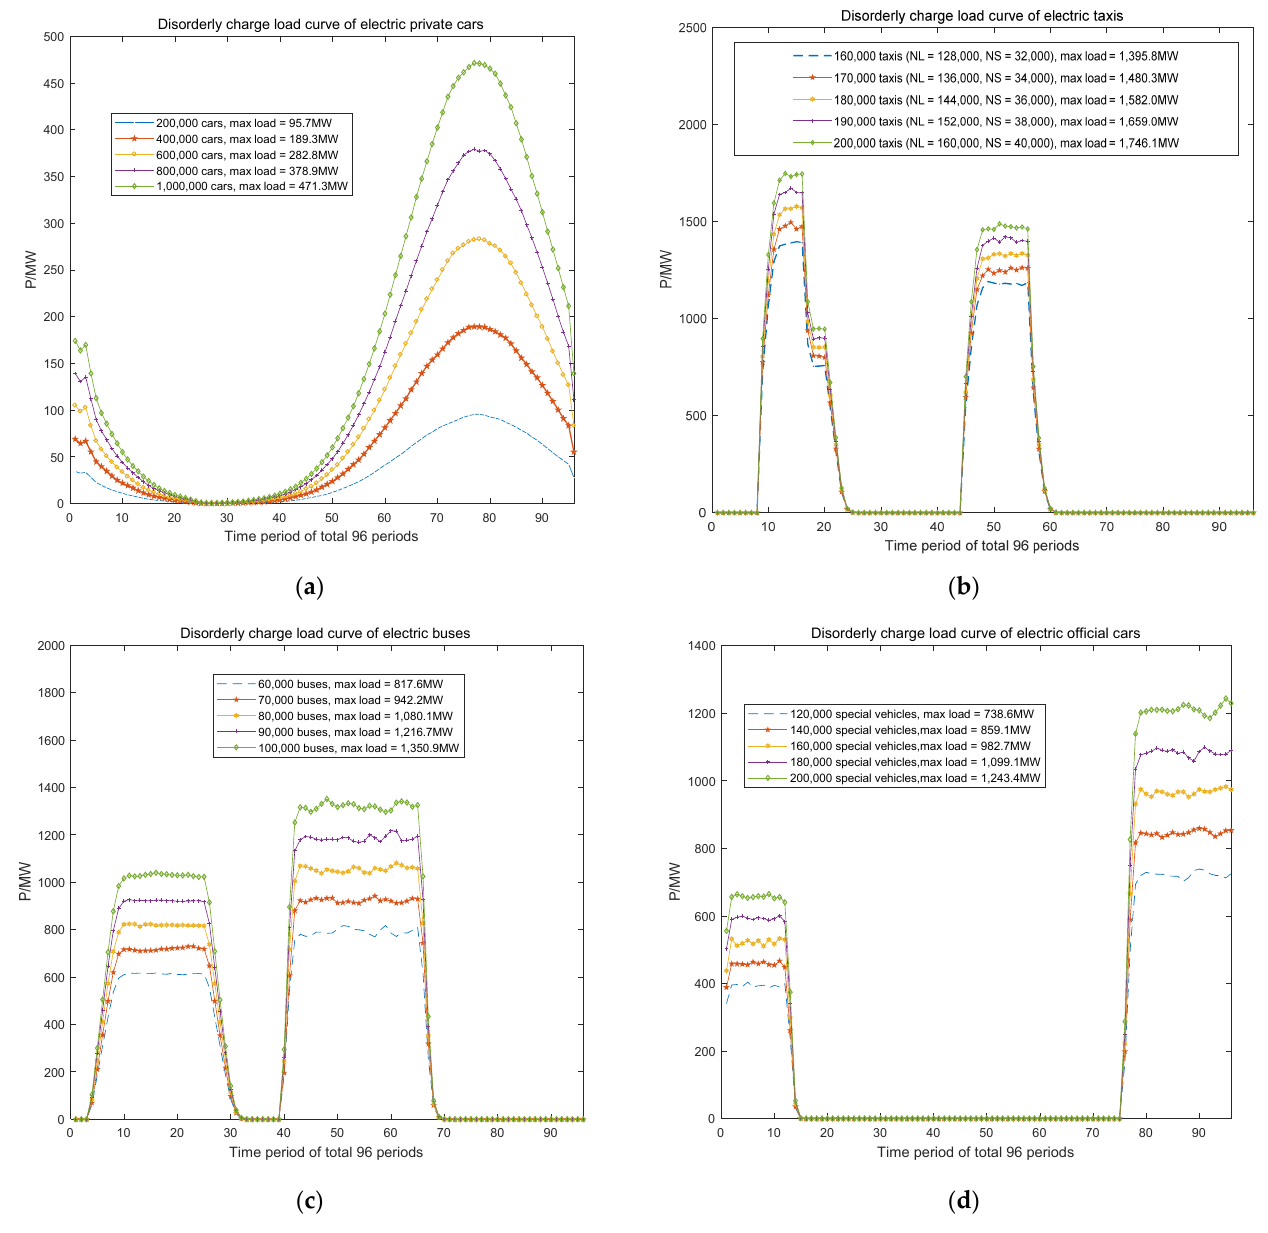
Figure 3. The disorderly charging load curve of EVs: ( a ) private cars; ( b ) taxis; ( c ) buses; ( d ) official and special vehicles.